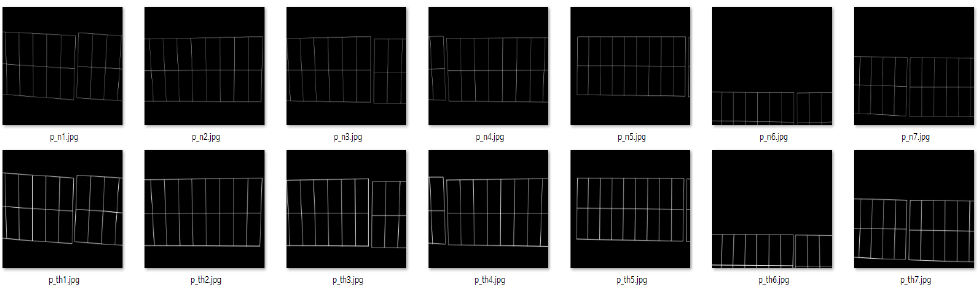
Figure 15. Ground-true images for evaluating matching consistency.